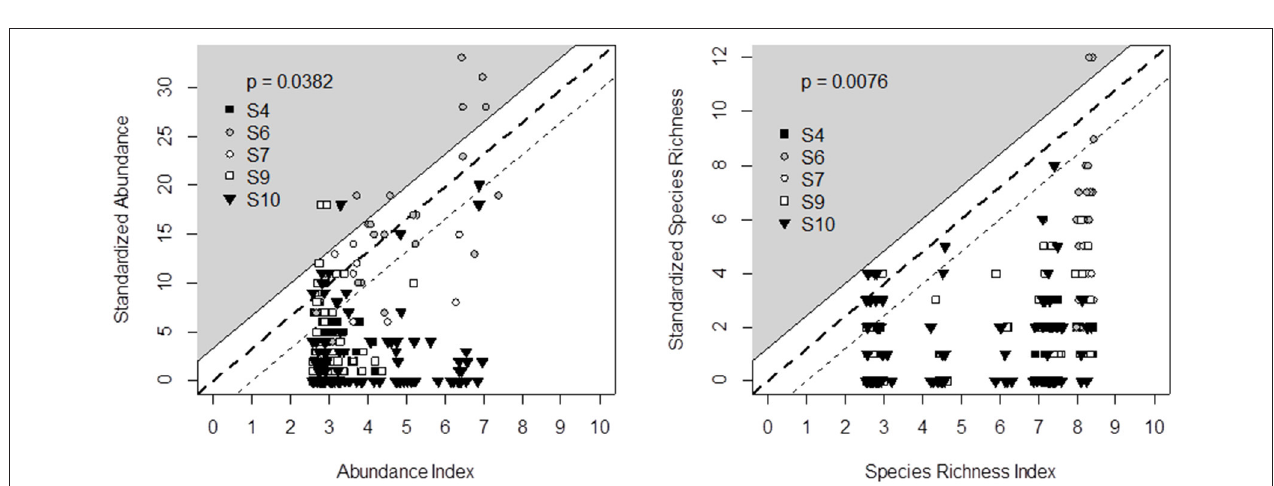
FIGURE 4 | Comparison of decision tree output (X-axis) and field data recorded in five experimental surveys (Y-axis) across Switzerland (S4), France (S6, S7, S10), and Wales (S9) for bumblebee abundance (left) and species richness (right). Principles for defining the triangle-shaped validation area and associated p -values are given in Figure 2